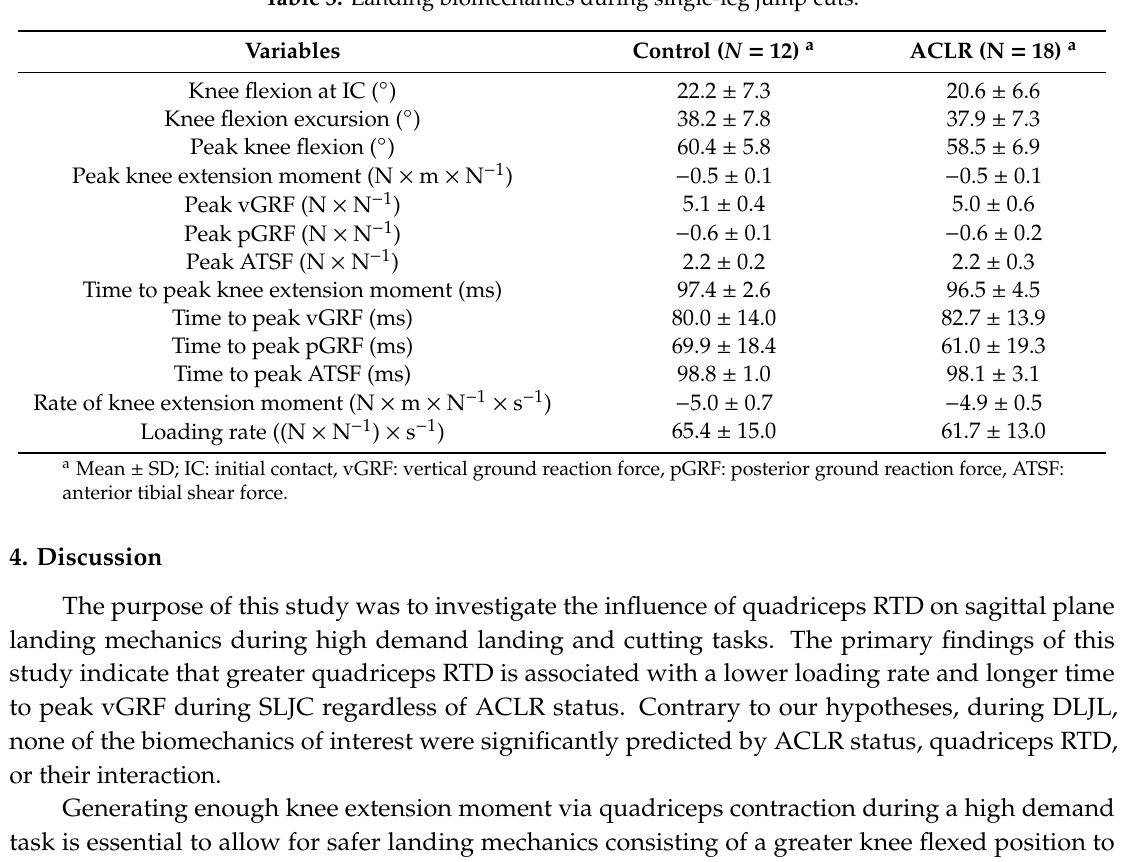
Table 3. Landing biomechanics during single-leg jump